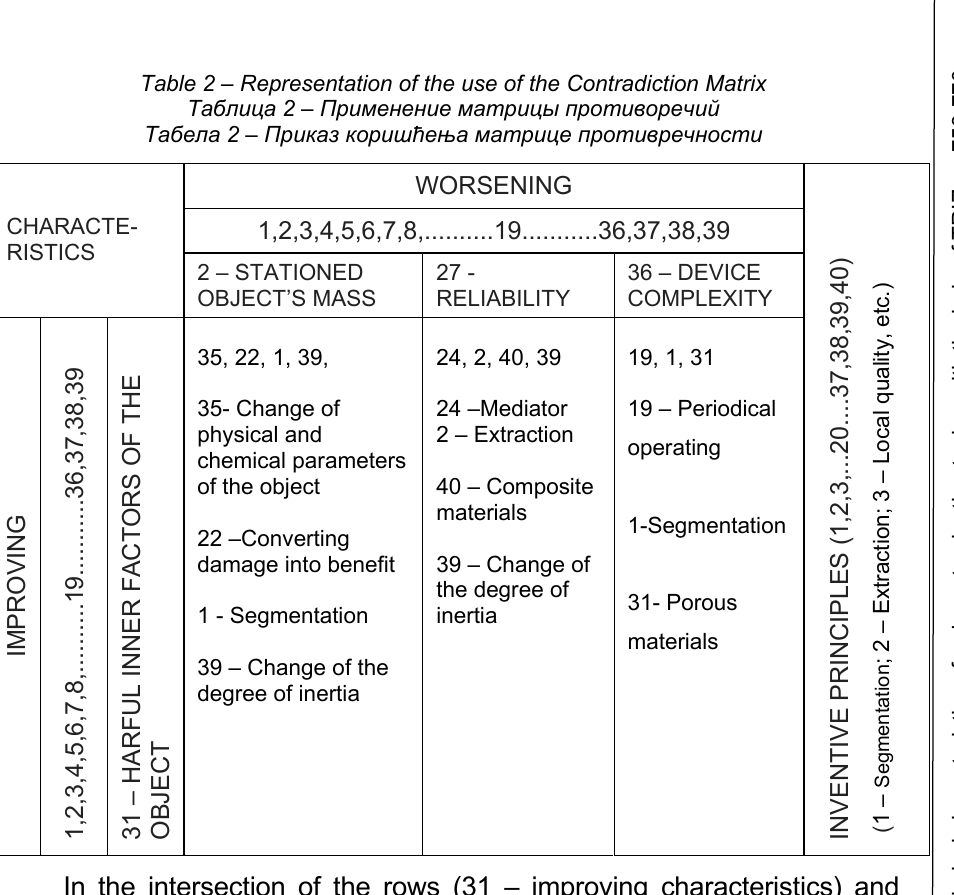
770 Table 2 – Representation of the use of the Contradiction Matrix